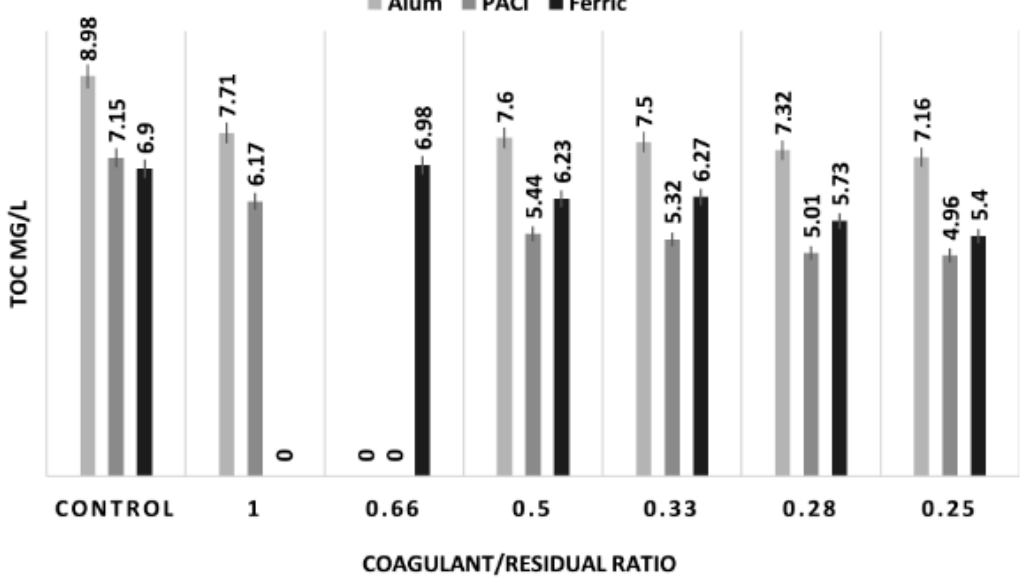
Figure 2. Surface water treatment using selected five C/R ratios based on net positive reduction in (C / R > 1 didn’t result in additional TOC TOC (C/R > 1 didn’t result in additional TOC removal).